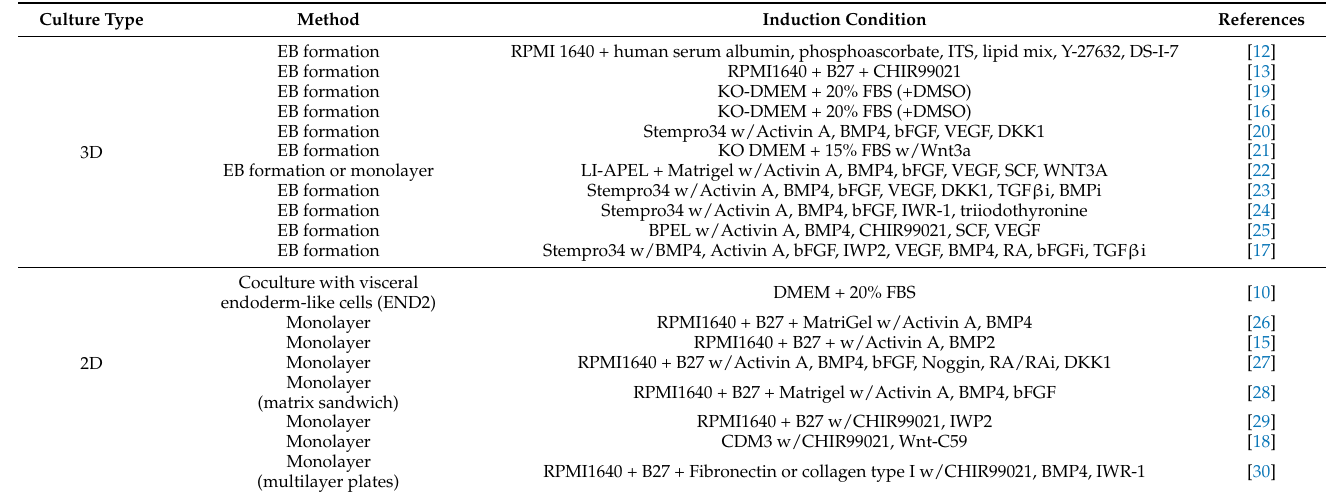
Table 1. Cardiac differentiation protocols from human pluripotent stem